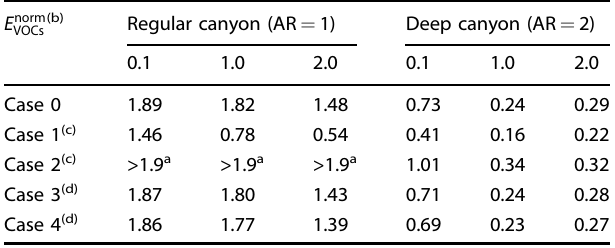
Table 1. The “ wiggle room ” ( χ , dimensionless) under the hourly NO 2 compliance line (a) .